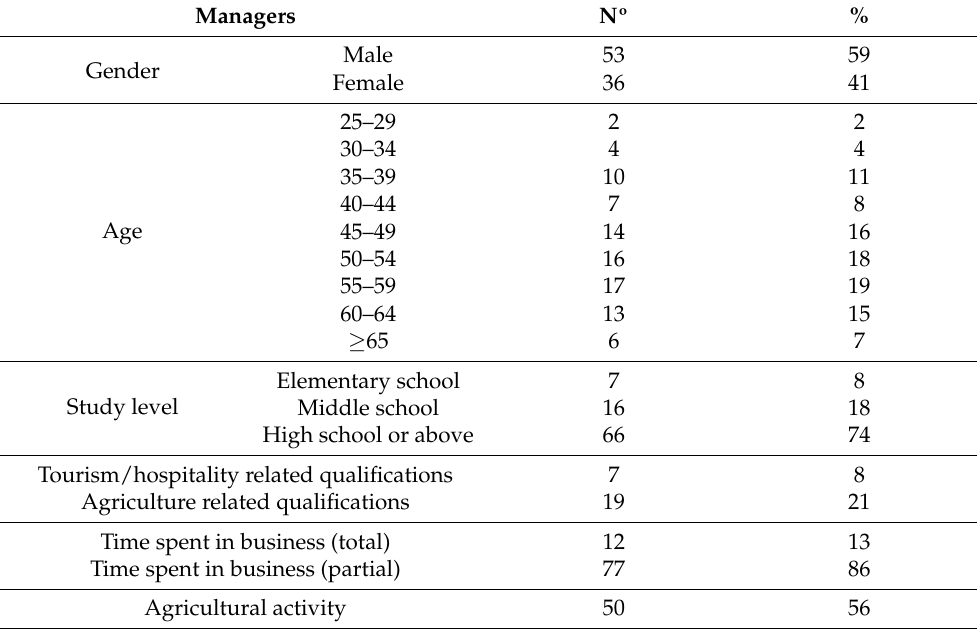
Table 1. Profile of